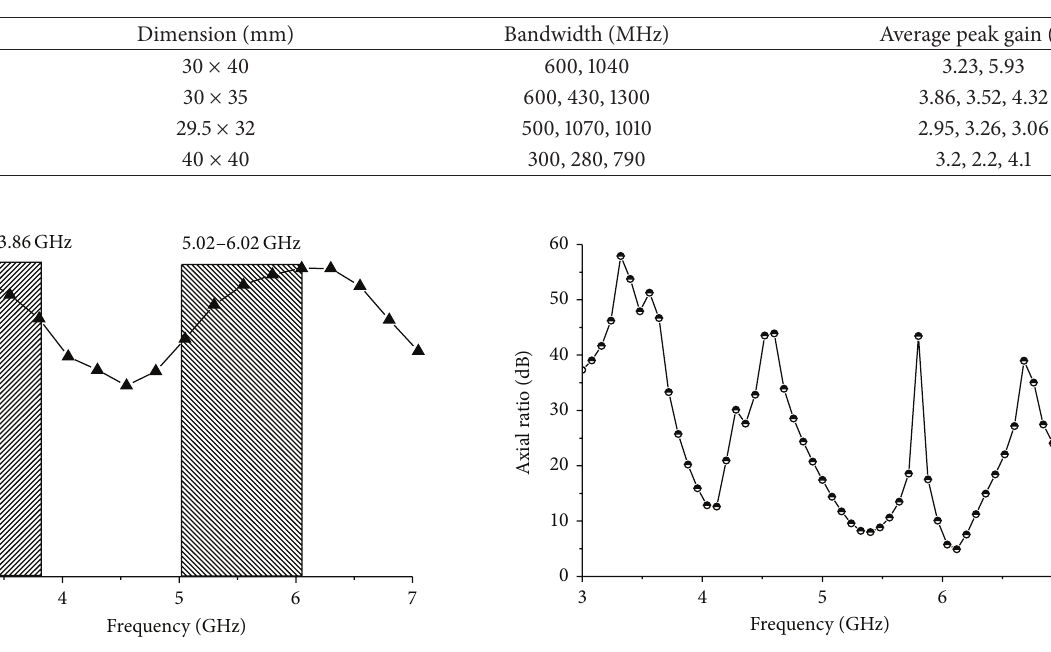
Table 2: Comparison between proposed and some existing antennas.